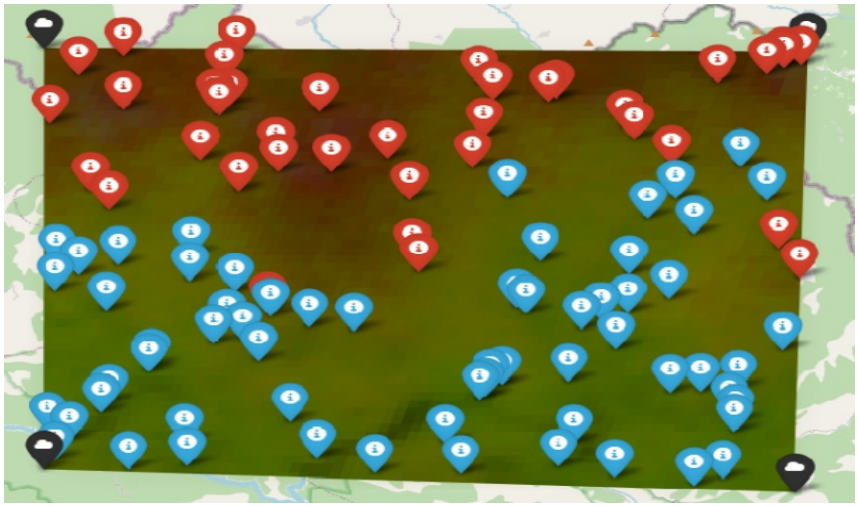
Figure 7. Results from the application of time series clustering algorithm.